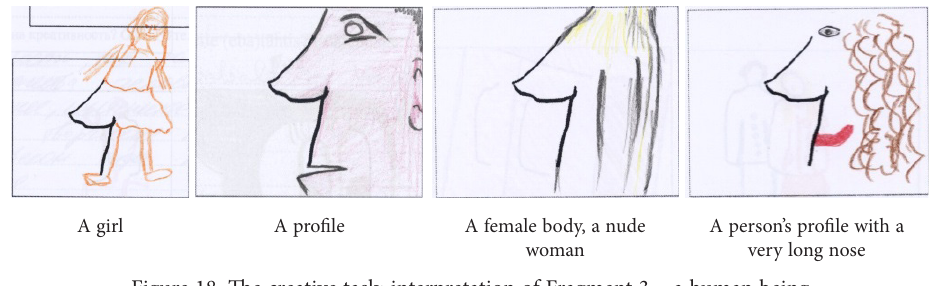
Figure 18. The creative task: interpretation of Fragment 3 – a human being (source: testingmom.com, 2020) It was noticed that two fifths (40.0%) of Estonian and almost three fourths (73.7%) of Slovenian students linked the fragment with a human being in the processes of association and interpretation (Tables 5, 6). Table 5. Associations of Fragment 3 (%) (source: created by authors) In total Lithuania Latvia Estonia Slovenia